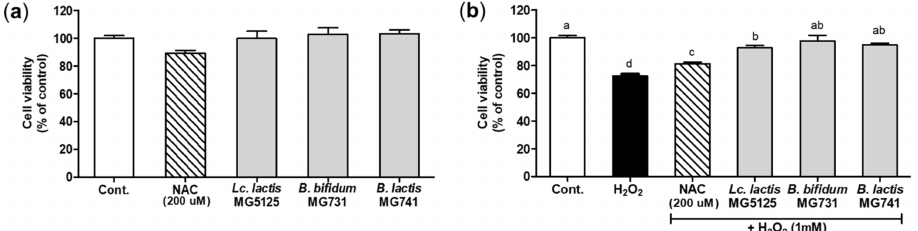
Figure 2. Effect of probiotics on viability of hepatocytes measured by the MTT assay. ( a ) Effect on viability of hepatocytes treated with Lc. lactis MG5125, B. bifidum MG731, and B. lactis MG741 (2%). ( b ) Cytoprotective effect of Lc. lactis MG5125, B. bifidum MG731, and B. lactis MG741 on H 2 O 2 -exposed hepatocytes. The cells were pretreated with the CFS of probiotics (2%) for 24 h and then exposed to H 2 O 2 (1 mM) for 24 h. The data represent the mean ± SEM ( n = 3). Different letters among columns indicate significance at p < 0.05, as determined by Duncan’s test. Cont., control; NAC, N